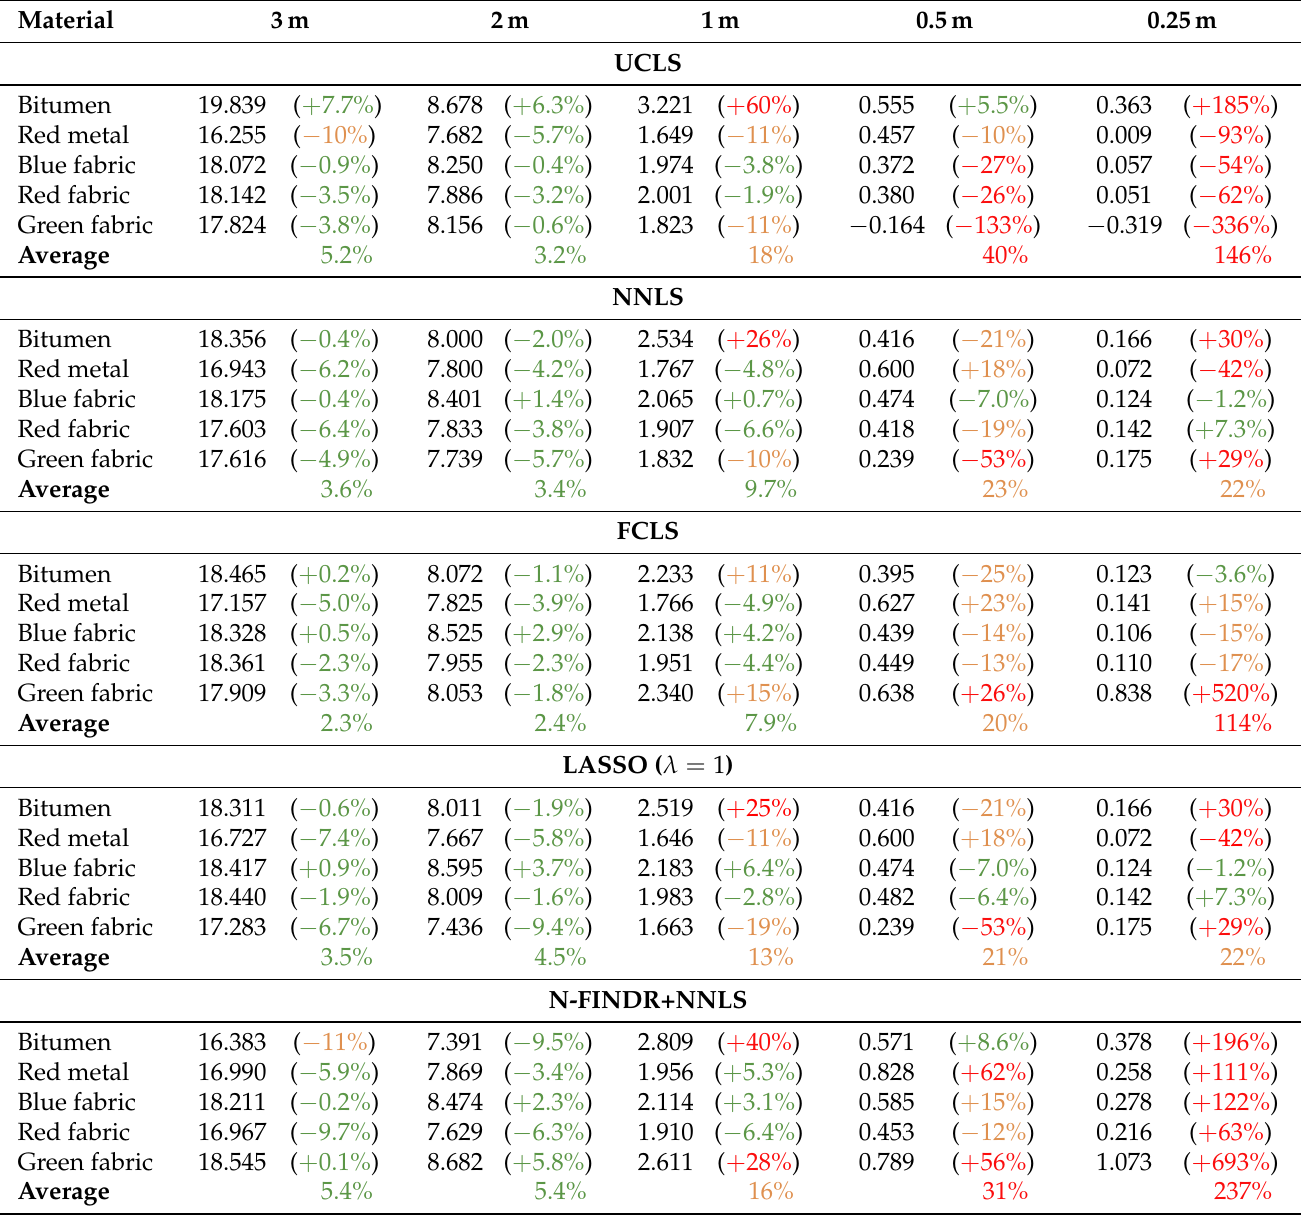
Table 2. Target areas derived from abundance estimation for the DLR HySU benchmark. The estimated areas are shown in black in units of pixels and can be compared to the actual measured areas in Table A2. For convenience, we report the signed relative error ( ˆ A t A t ) / A t in parentheses and color code it to green when its absolute value is below 10%, orange − ˆ A between 10 and 25% and red above 25%. The unsigned relative error t − A t | / A t is also recorded for each algorithm and | target size averaged over the target